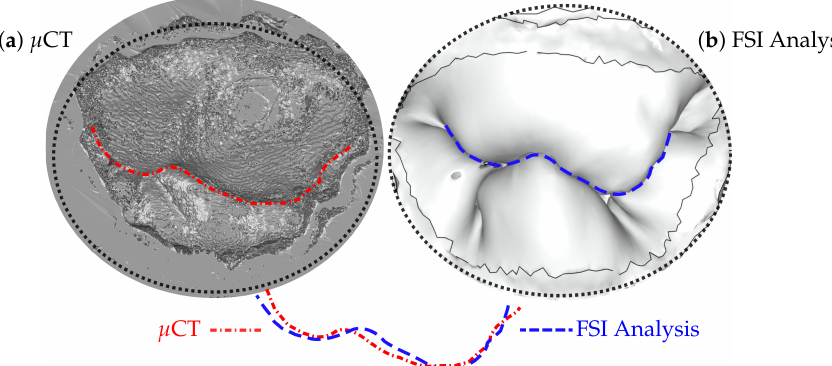
Figure 3. Closed leaflets reconstructed from µ CT images ( a ) compared to the results of fluid–structure interaction (FSI) simulations ( b ), after balancing all the structures involved [40]. The curves represent the coaptation line where the posterior and anterior leaflets are in